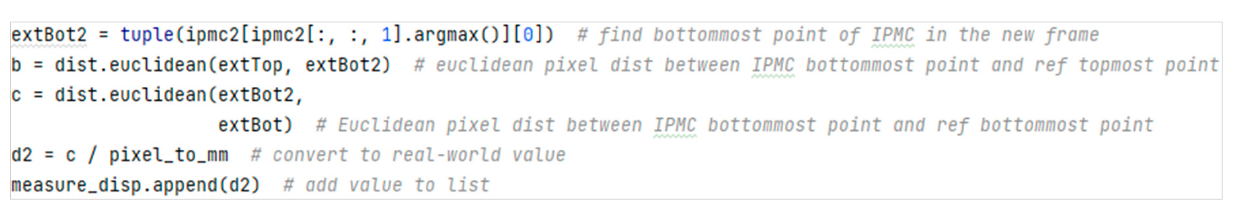
Figure 7. Lines 63 to 68 of the code.